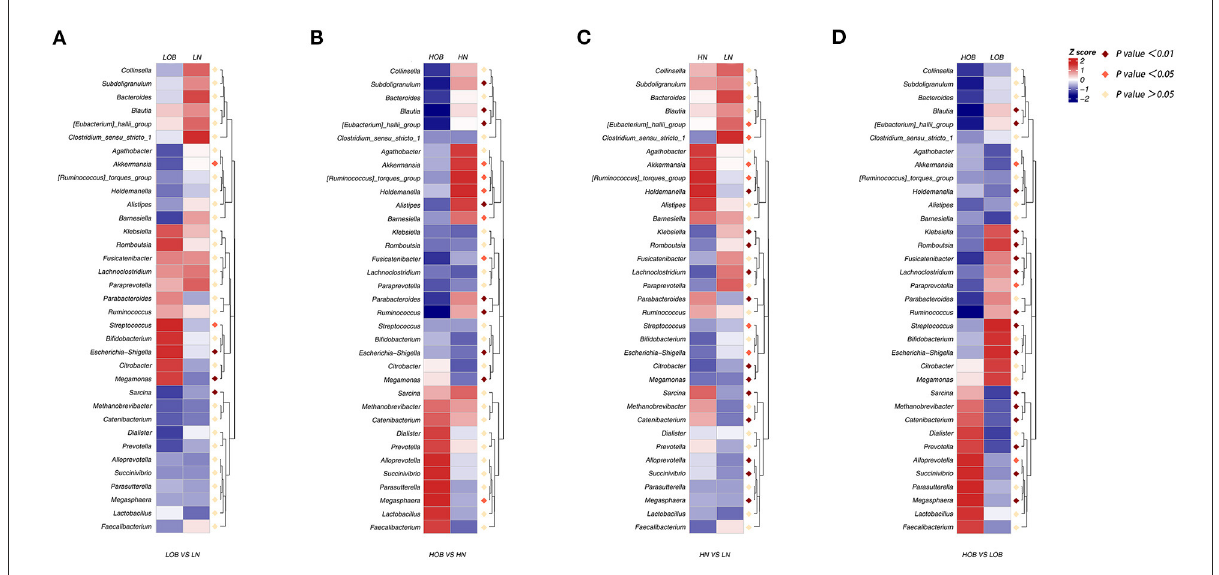
FIGURE4 (A–D) MetaStats analysis, in which the abundances of the 35 most significantly different taxa in the two groups are shown in heatmap. Purple dot represents a high significant difference ( p < 0.01), red dot represents a significant difference ( p < 0.05), and yellow dot represents no significant difference ( p > 0.05). LN, low-altitude normal weight children; LOB, low-altitude obese children; HN, high-altitude normal weight children; HOB, high-altitude obese